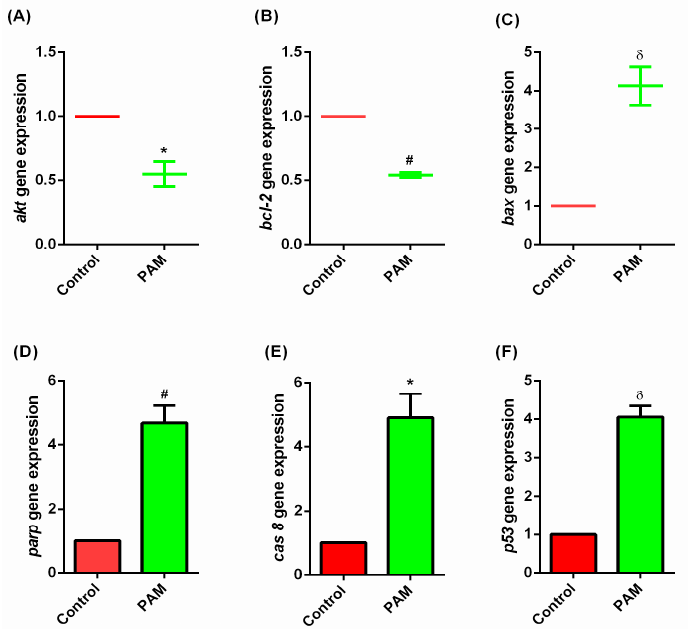
Figure 4. Gene expression study of melanoma cells. mRNA ( Akt , Bcl-2 , Bax, Parp, Casp8, P53 ) expression changes during PAM treatment on the 21st day. Bars plotted represent the mean and SD of the mean, n = 3, * p < 0.05; δ p < 0.01, # p < 0.001.